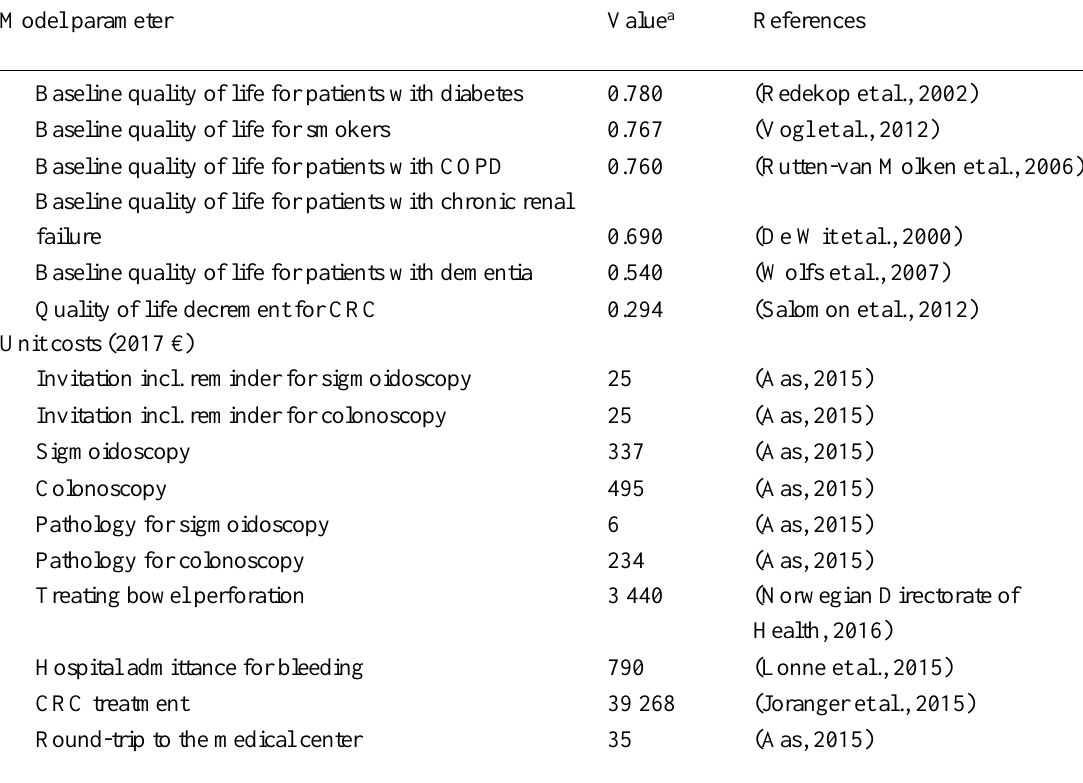
Values for key model parameters used in the analysis. Costs in 2017